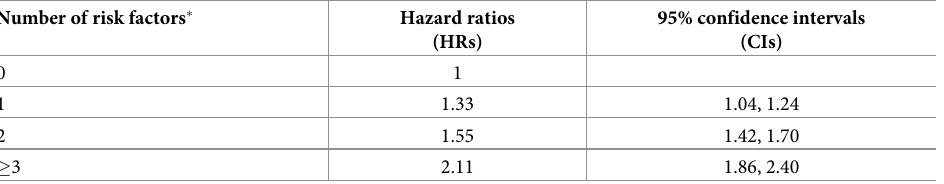
Table 3. Number of risk factors as a predictor of the development of endometrial neoplasia in Cox multivariate regression modeling. Number of risk factors